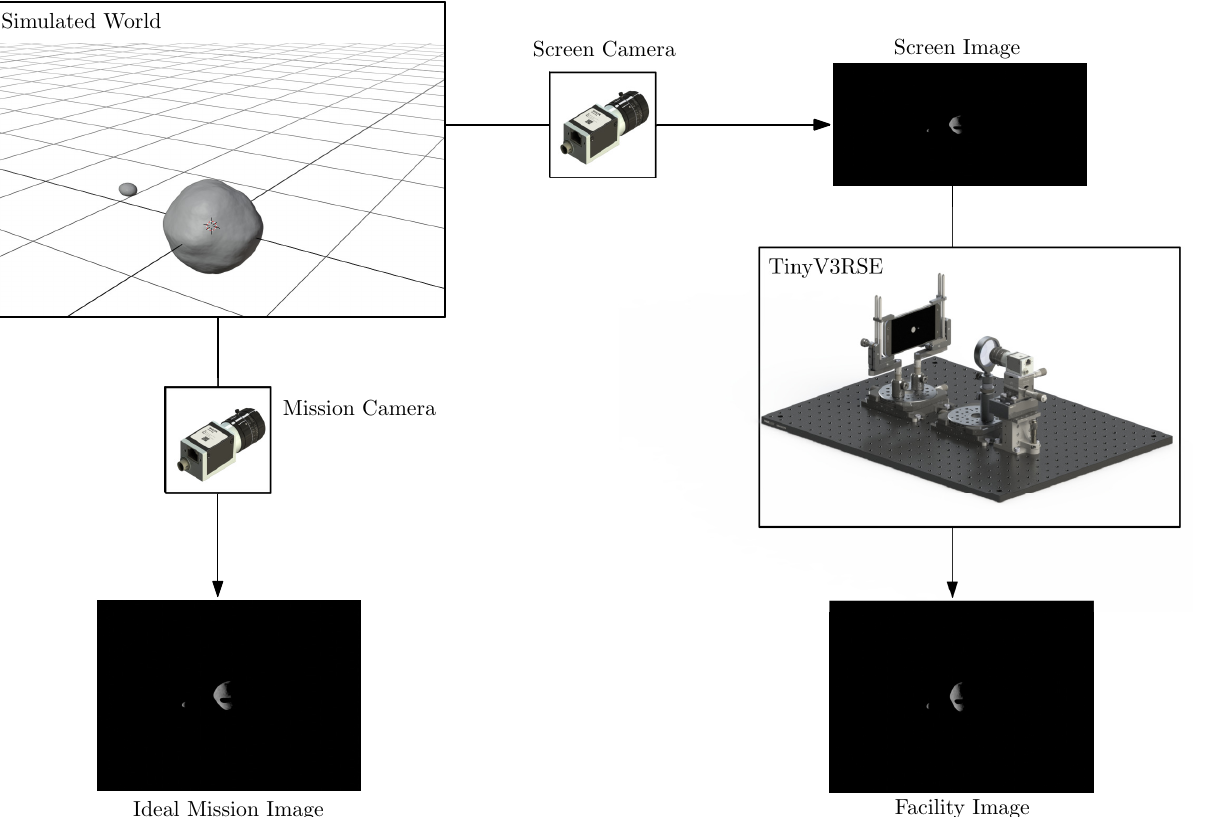
Figure 5. Functional workflow in